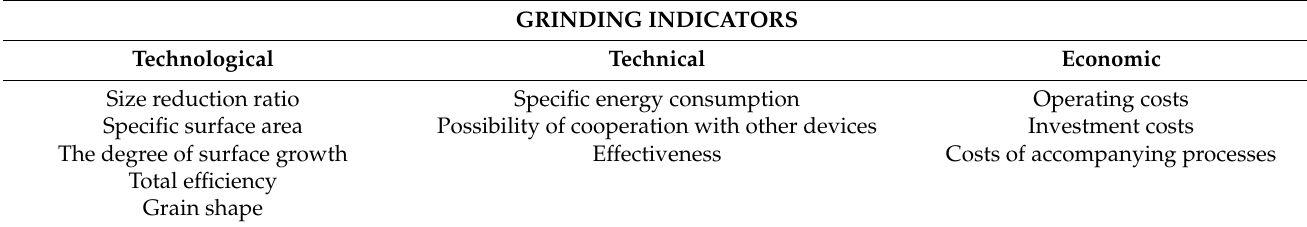
Table 6. Grinding indicators classification according to Macko [173].